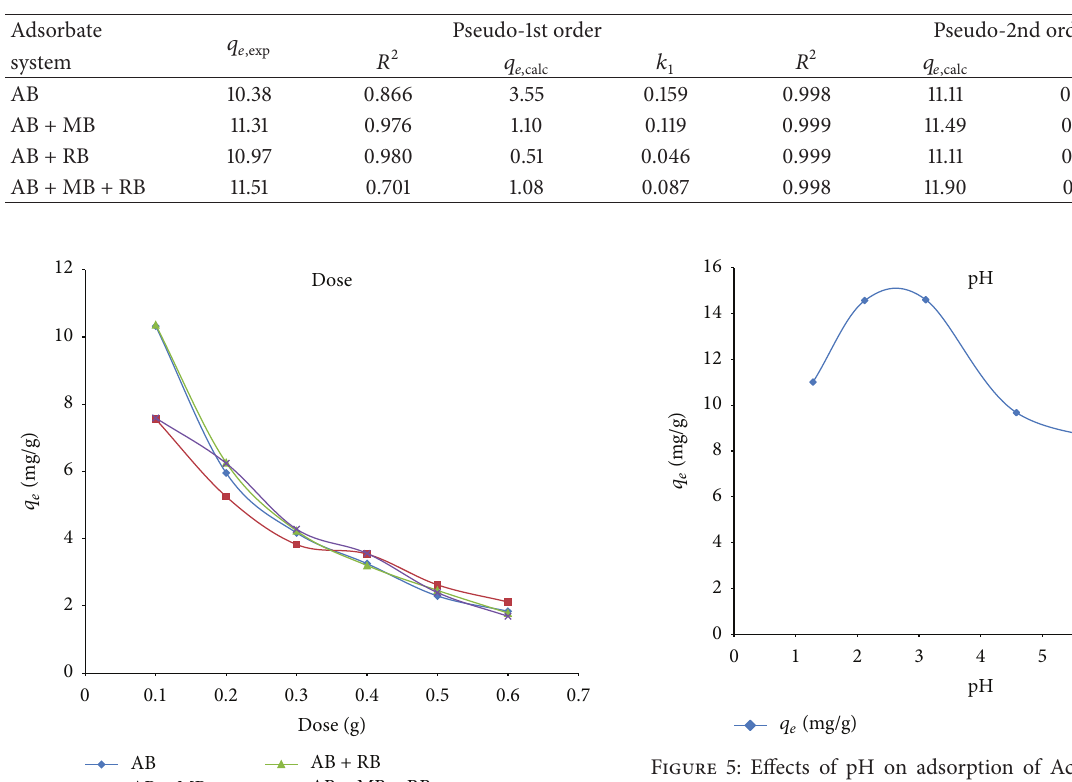
Table 1: Kinetics parameters for adsorption of Acid Blue 161 onto raw sawdust.